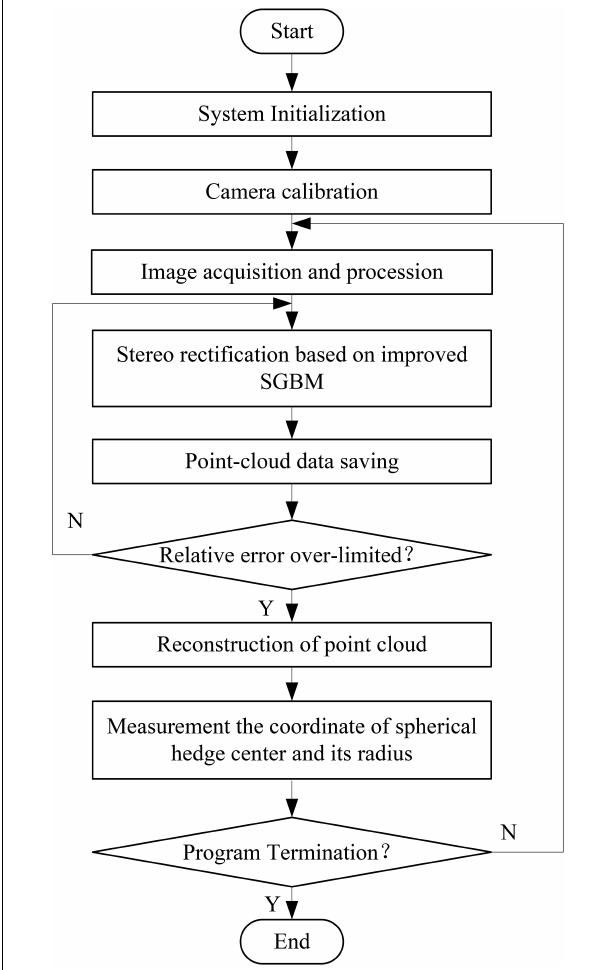
FIGURE 2 | Flow chart of the measurement system.